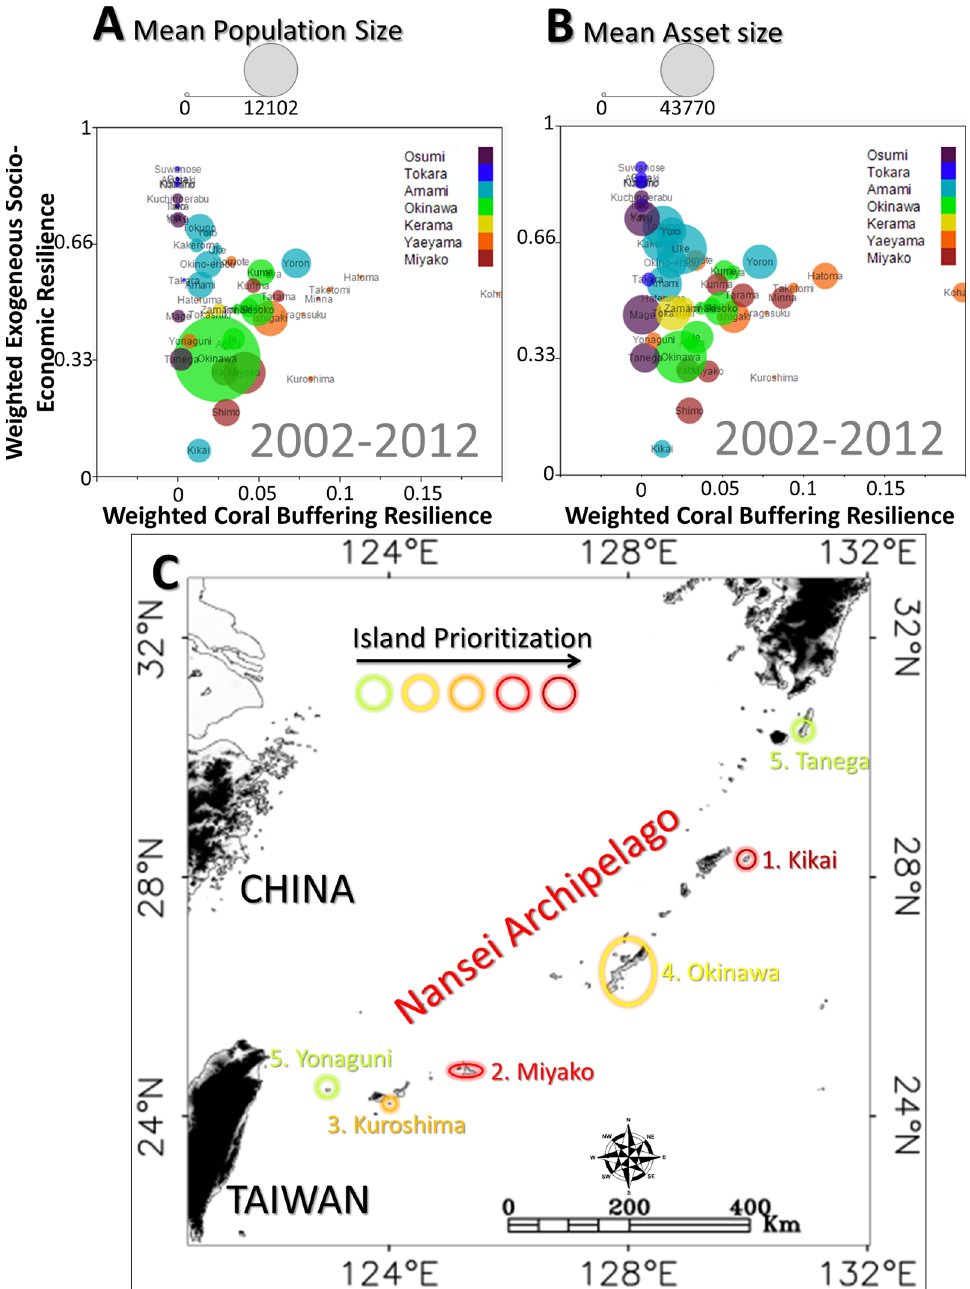
Figure 11. Island-scale bubble plots of the ( A ) population-sized and ( B ) asset-sized exogeneous socio-economic resilience with the coral buffering resilience as weighted by the factor influences found in the literature and colored by the Nansei sub-archipelagoes for 2002–2012. ( C ) Nansei map of coastal management